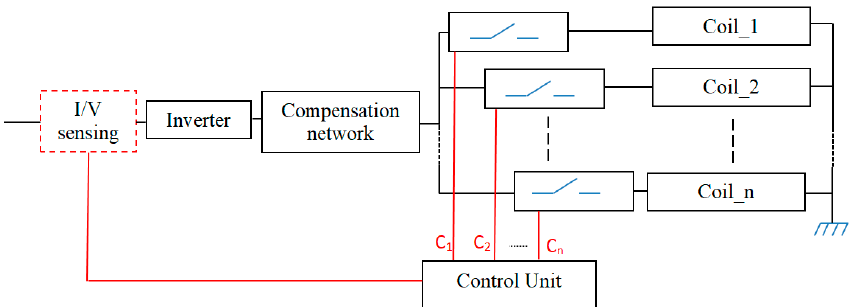
Figure 10. Transmitting coils connection scheme.